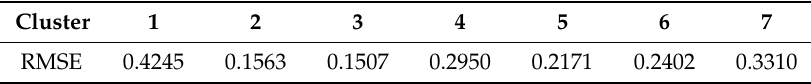
Table 4. Performance evaluation of neural models for the testing group.